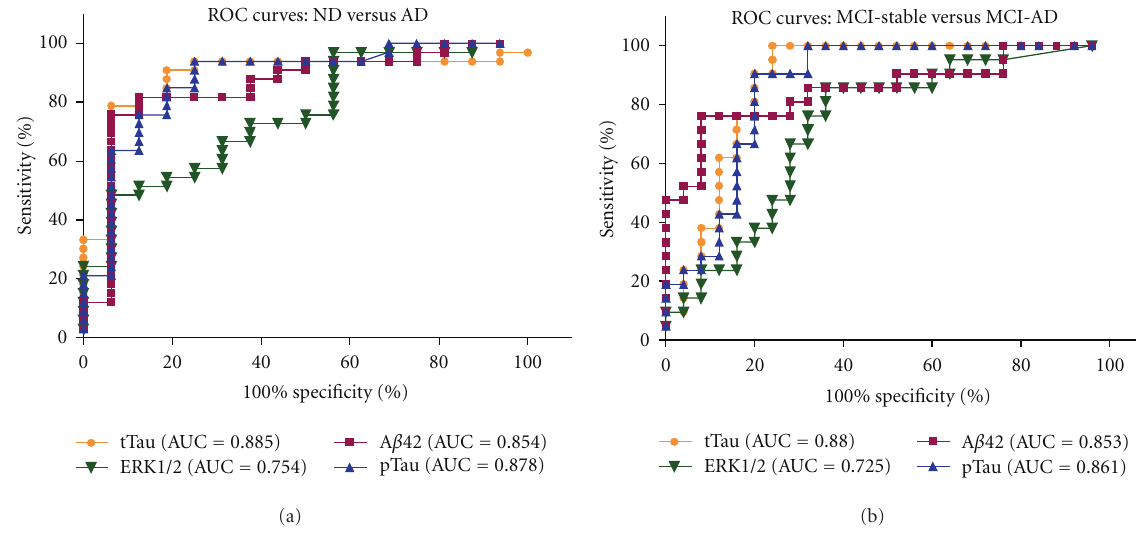
Figure 4: ROC curves for CSF-ERK1/2 levels and classical biomarkers: (a) ROC curves for A β 42, tTau, pTau, and ERK1/2 (at baseline) for the discrimination between ND and AD. (b) ROC curves for A β 42, tTau, pTau, and ERK1/2 (at baseline) for the discrimination between MCI-stable and MCI-AD. AUC: area under the curve. ERK1/2 measurements below LLOD are reported as 39pg/mL in (a) and (b).